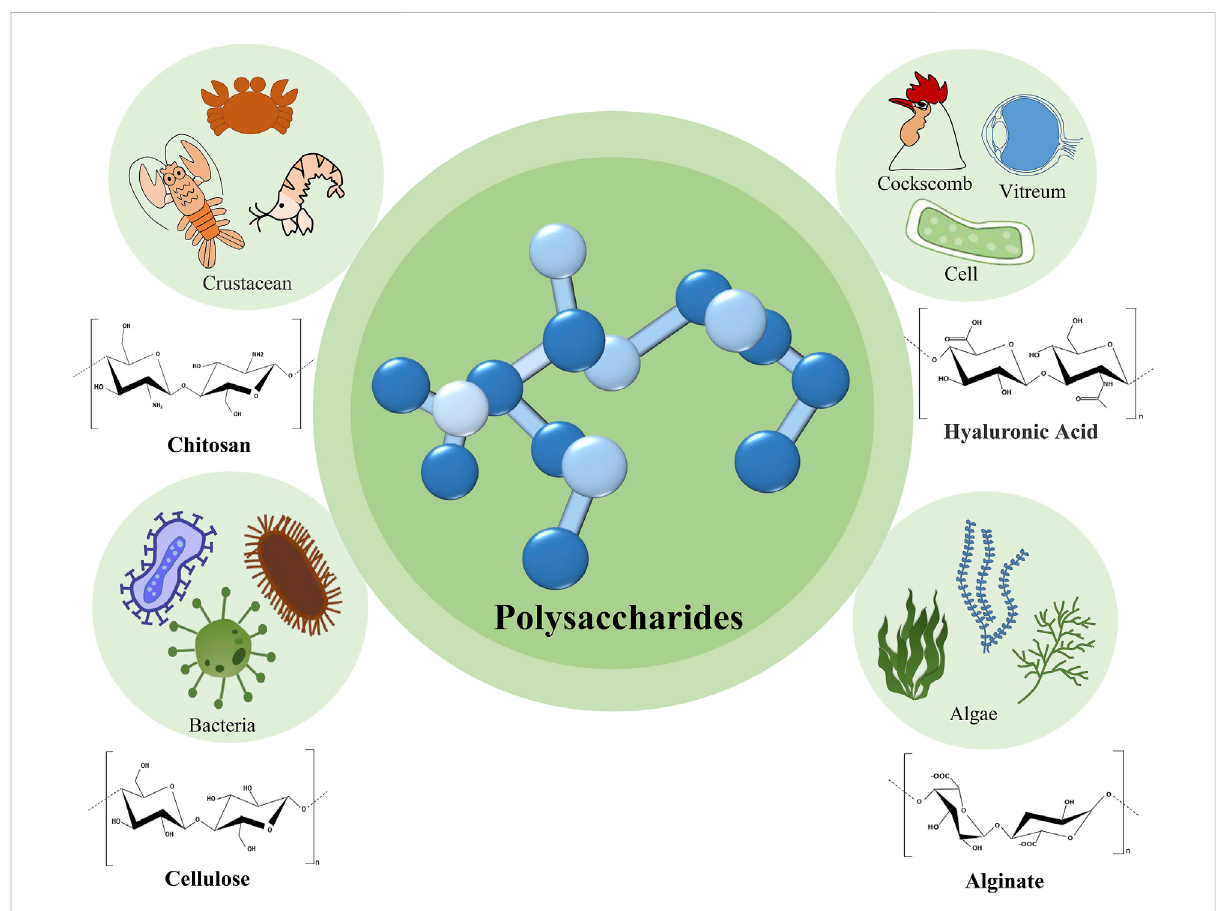
FIGURE 1 The sources and structures of the commonly used